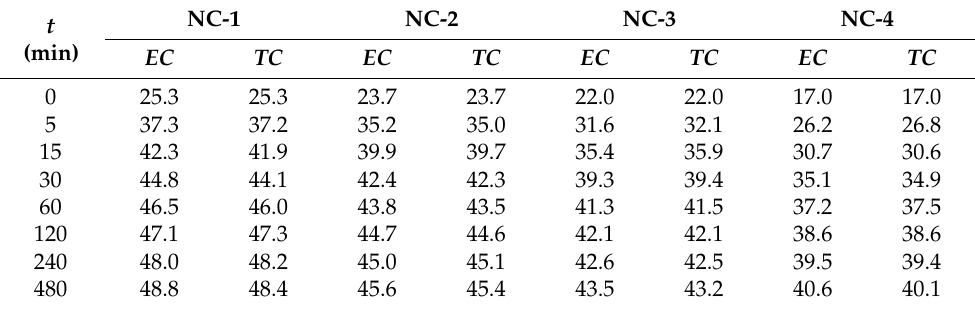
Figure 10. Variation of conductivity and theoretical fitting curve of alloys aged at 500 °C. ( a ) NC-1 alloy; ( b ) NC-2 alloy; ( c ) NC-3 alloy; ( d ) NC-4 alloy. Table 10. The conversion rate and corresponding conductivity of alloys aged at 500 °C for differ- ent times.